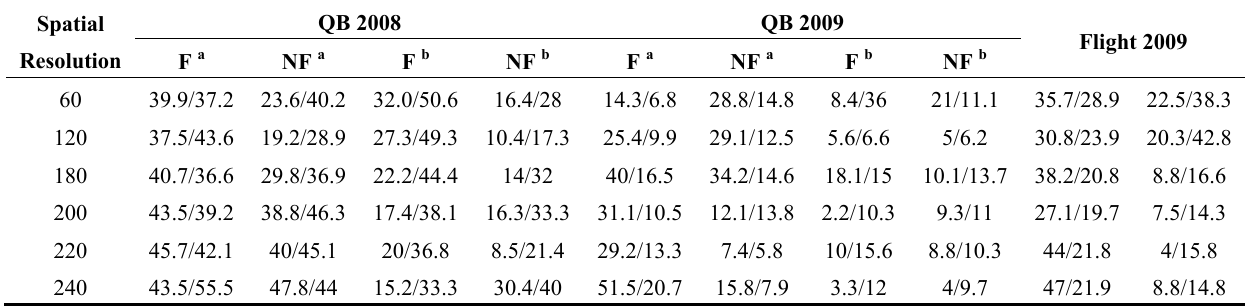
Table 6. Comparison between images based in the producer and user (P/U) index values for the Pyrus class. Values with symbol a and b were classified with the ML and SVM methods, respectively. For the Flight 2009 image, left and right,